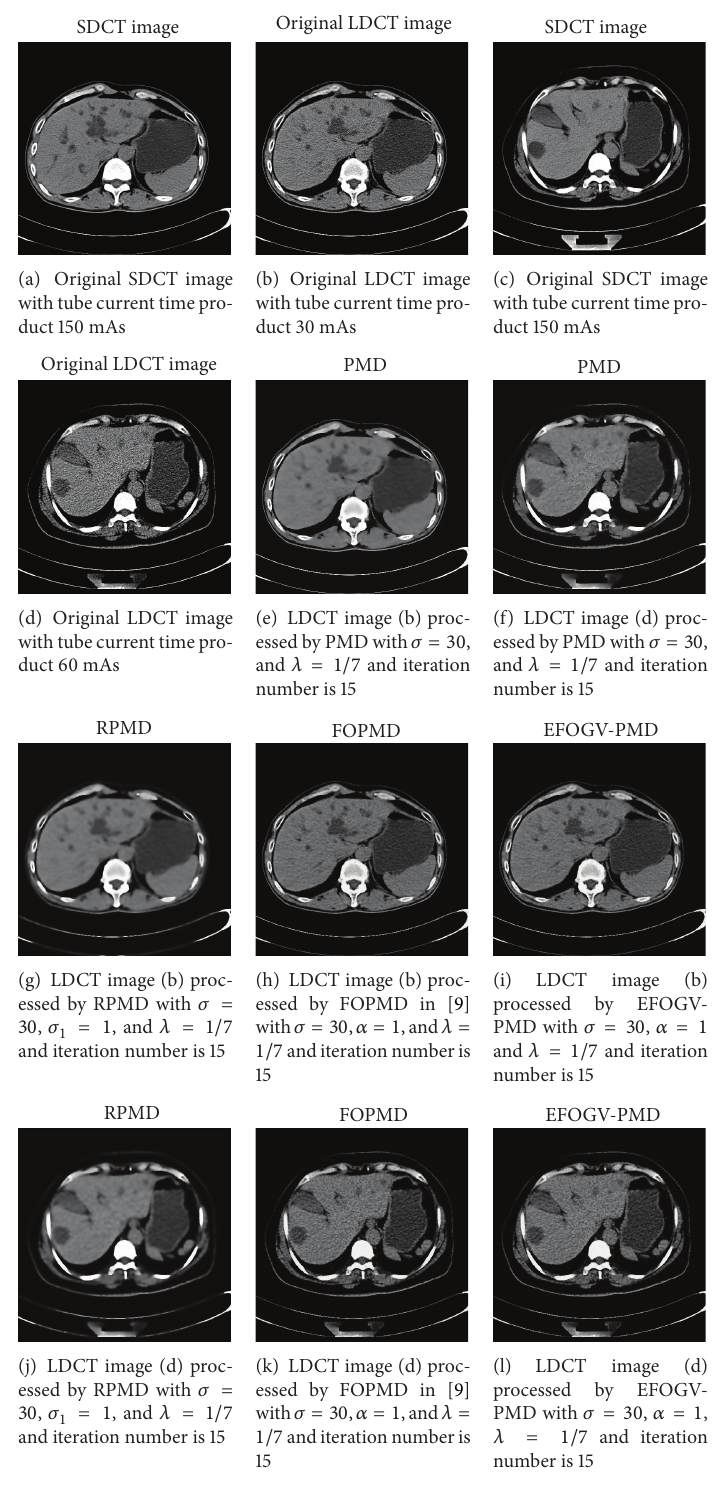
Figure 1: Original SDCT and LDCT images ((a)–(d)), LDCT images processed by PMD, RPMD, FOPMD and EFOGV-PMD with fractional- order 𝛼 = 1 and iteration number is